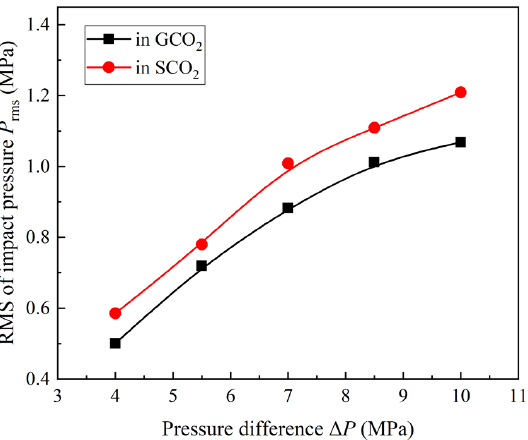
Figure 8. Variations of the pressure oscillation intension with increasing pressure difference. Ex- perimental conditions: Δ P = 4–10 MPa, 7 ≤ L c / D ≤ 9, and P a = 6 or 8.5 MPa. mental conditions: ∆ P = 4–10 MPa, 7 ≤ L c / D ≤ 9, and P a = 6 or 8.5